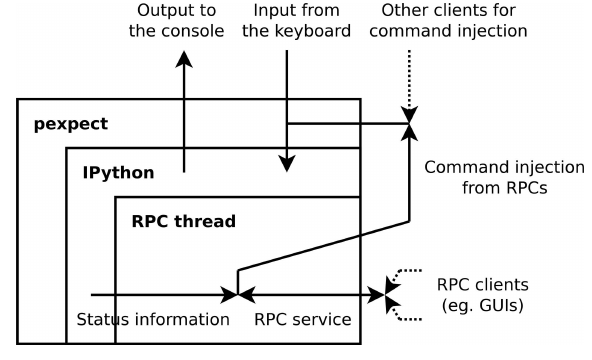
Figure 2 Mamba ’s communication architecture.